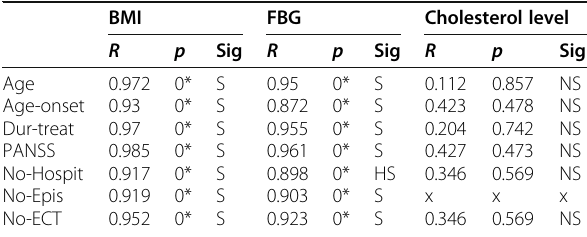
Table 2 Correlations of patients ’ group metabolic profile and clinical data